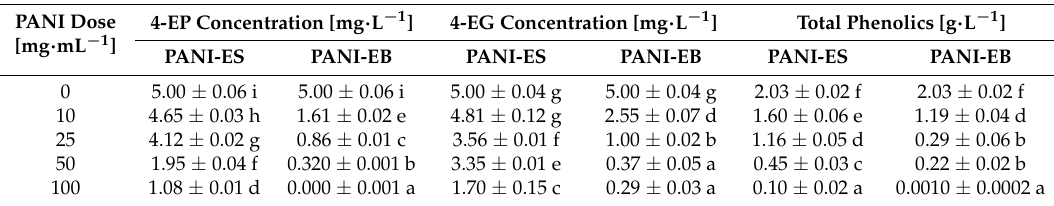
Table 1. Theinfluence of the addition of PANI polymers on the removal of 4-EP, 4-EG, and total phenolics in a red wine